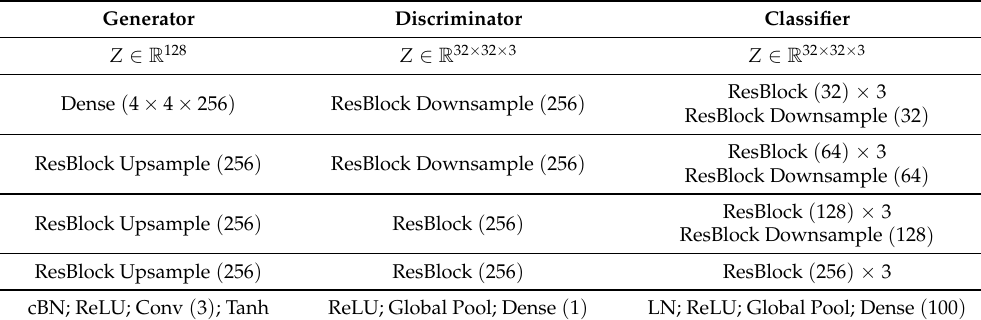
Table A1. Architecture of the neural network modules for the training of the CIFAR-100 dataset. The values in the brackets indicate the number of convolutional filters or nodes of the layers. Each ResBlock is composed of two convolutional layers. The difference between the architecture for the CIFAR-10 dataset is at the classifier, in which 256 filters are used in the last three ResBlocks.